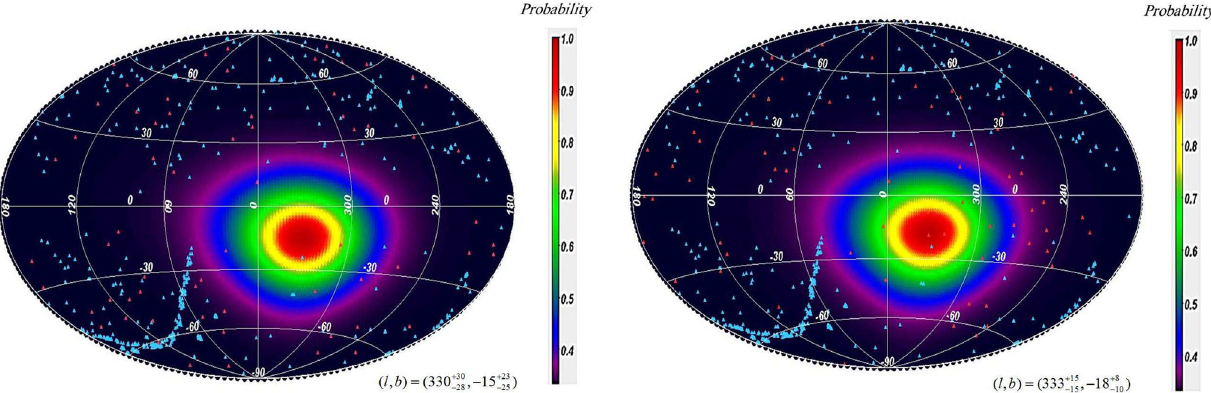
Fig. 2 Probability of dark energy dipole direction using 2 × 10 5 datapoints for Pantheon data . Left:Chameleon, Right:Teleparallel. White triangles denote Pantheon data